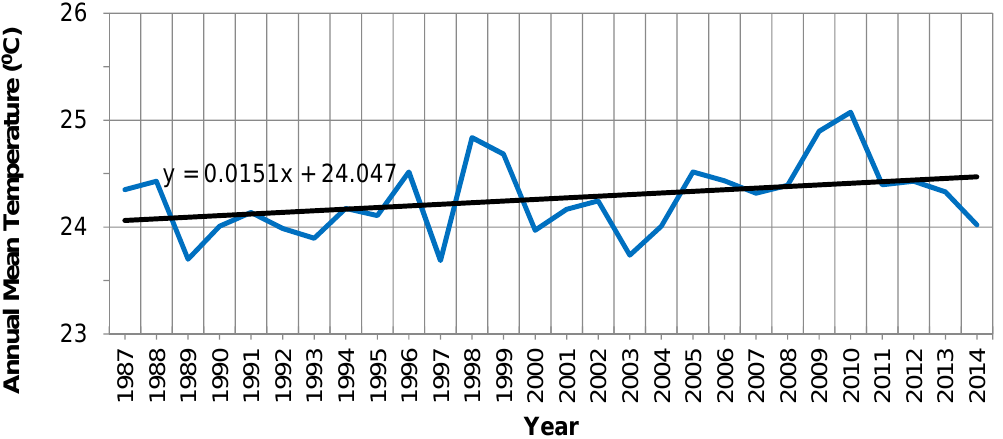
Figure 2. Annual mean temperature in the study area for the last 28 years. Table 3. Mann–Kendall test and Sen’s slope results of mean annual, maximum, and minimum temperatures for 1987 to 2014.